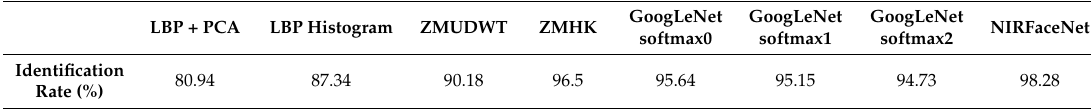
Table 4. Identification rates of various methods tested on Test Set 2.